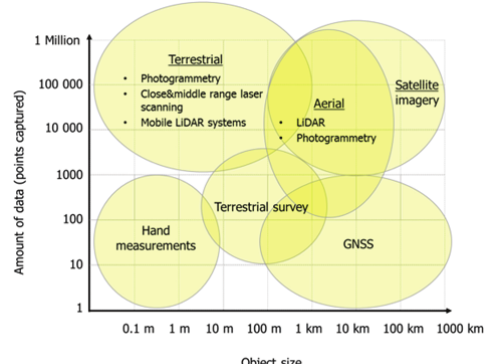
Figure 2. Three dimensional survey techniques characterised by scale and object size (derived from Böhler et al., 2001).